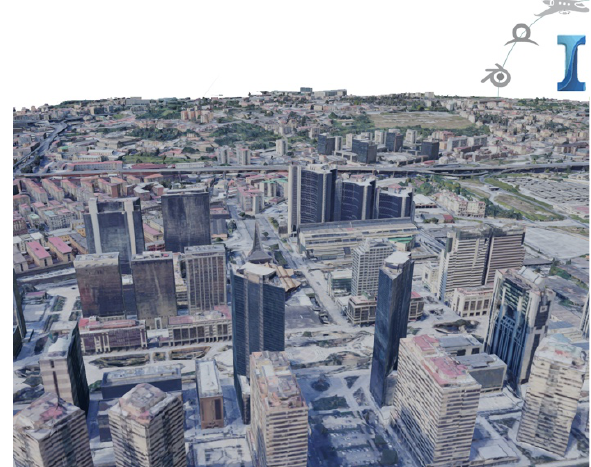
Figure 5 . Model acquired via the frame debugger and Blender